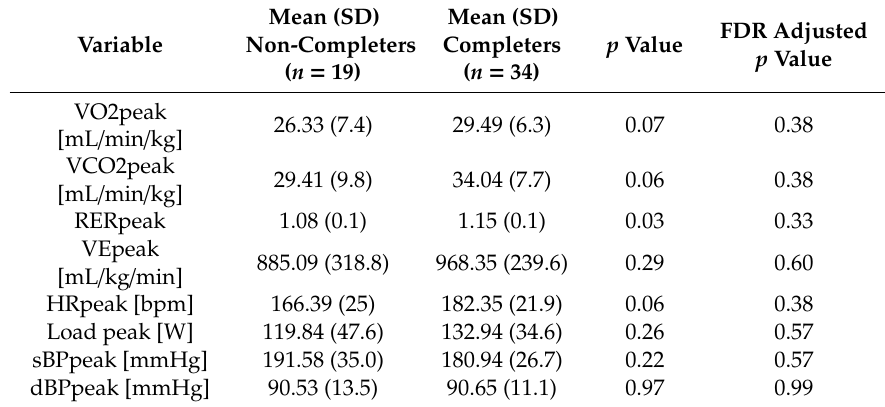
Table 5. Comparison of completers vs. non-completers before SEP in CPET parameters during maximal exercise.